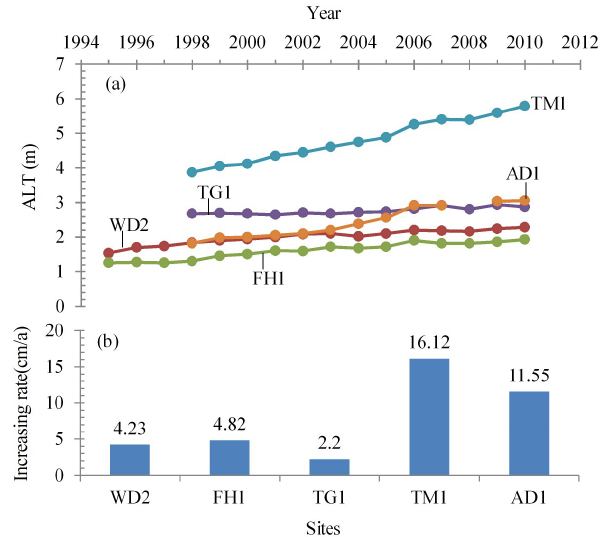
Fig. 2. Active layer thickness (ALT) along the Qinghai-Xizang (Ti- bet) Highway. (a) ALT. (b) Increasing rate of ALT. The increasing rate was estimated using linear regression for each site using 10 yr of ALT data with P < 0 . 05.